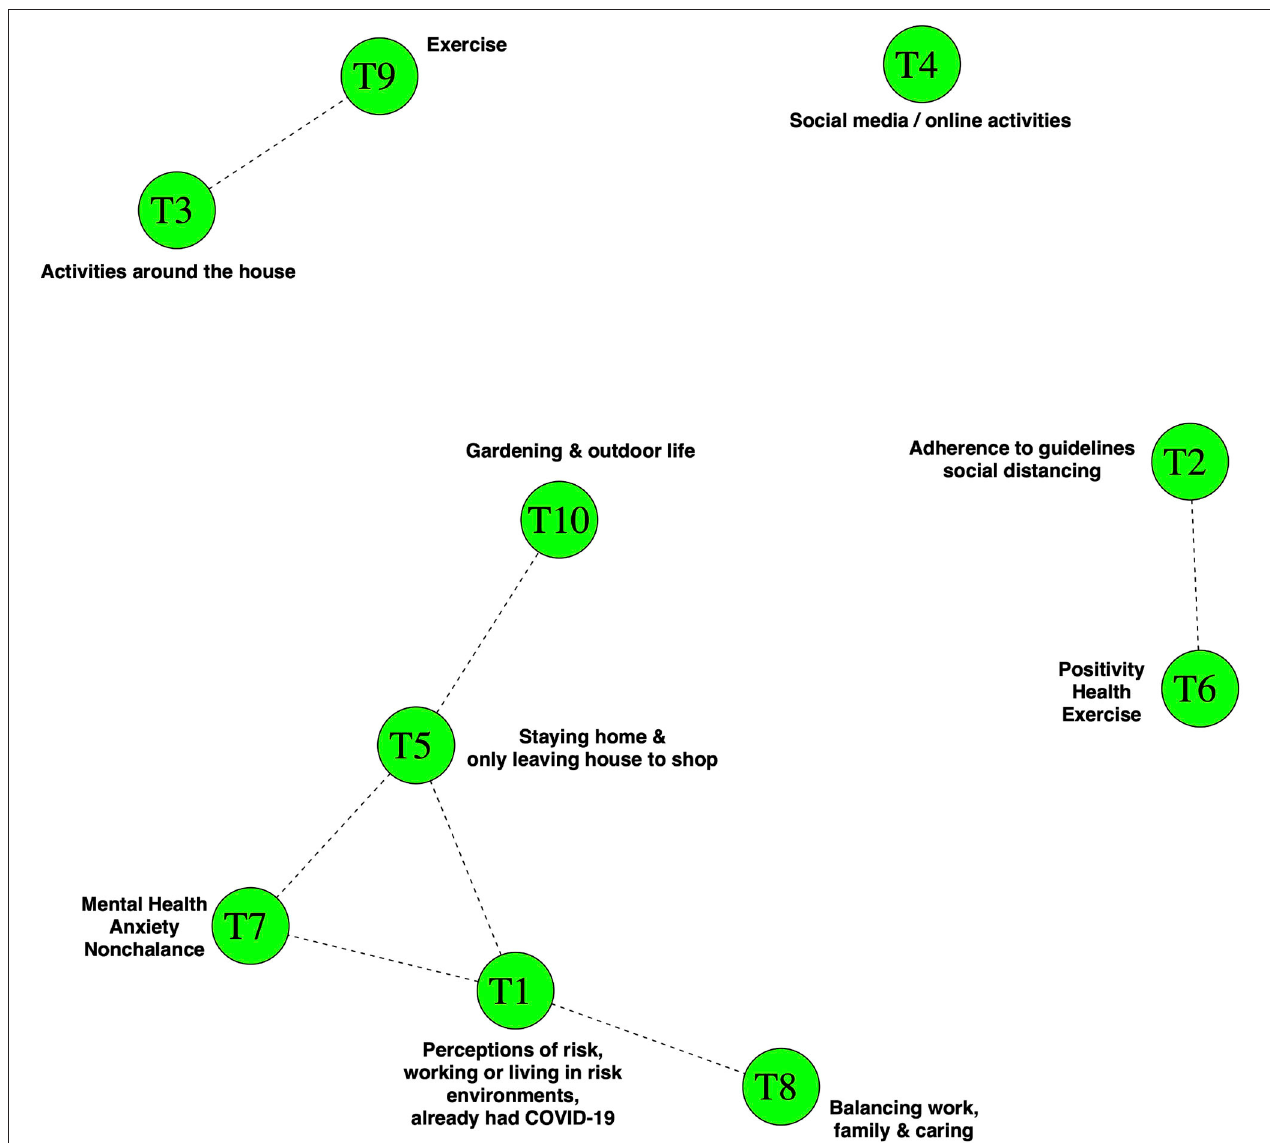
FIGURE 2 | Topic Correlations in the structural topic model for the corpus of text describing coping strategies. Nodes show topics and lines show positive correlations between the topics. There was a close correlation between topic T1 “Perceptions of risk, working or living in risk environments, already had COVID-19” and topics relating to mental health & anxiety (topic T7), strict adherence to social isolation practices (topic T5) and the balancing of ongoing work and family commitments (topic T8). Participants whose responses were focussed toward discussion of more intense PA (topic T9) or activities (including PA) around the house (topic T3) were less likely to also focus on T1, T7, T8, or T5. The topic correlation cut-off was